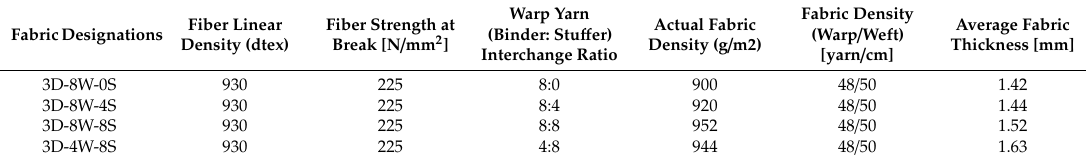
Table 1. Main properties of the yarn and the produced 3D warp interlock fabrics.